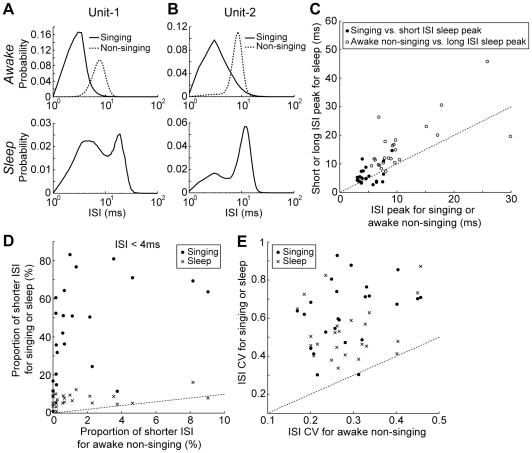
Comparison of interspike interval (ISI) among awake non-singing, singing, and sleep states.
A, top; ISI distributions of a pallidal unit for awake non-singing and singing period (dotted and solid lines, respectively). bottom; ISI distribution of the same unit for sleep period. Note evident bimodal distribution. The ISI distribution for singing state was generated from 87.1 seconds of singing. The ISI distributions for both awake non-singing and sleep states were generated from 120 seconds of each behavioral state. Data from the same unit appeared in Fig. 2A–D. B, Another example of ISI distributions for different behavioral states. Data are shown as in A. The ISI distribution for singing state was generated from 65.7 seconds of singing, and those for both awake non-singing and sleep states were generated from120 seconds of each state. Data from the same unit appeared in Fig. 2E–H. C, Comparisons of ISI peak times between awake and sleep state. ISI peak for singing vs. short ISI peaks for sleep (filled circles). ISI peak for awake non-singing vs. long ISI peaks for sleep (open circles). D, Population summary of proportion of shorter ISI (ISI <4 ms) for different behavioral states. E, Comparison of ISI CV (coefficient of variation) between different behavioral states across population. Data from 24 units in C–E.